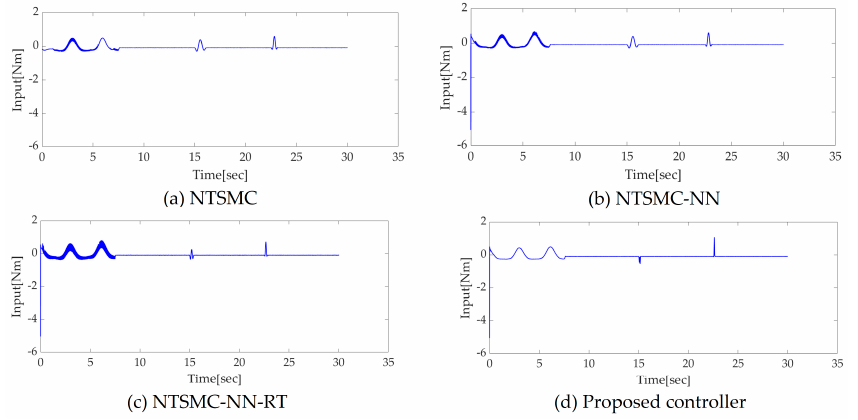
Figure 20. Mixed input θ 1 control input performance. ( a ) NTSMC input result; ( b ) NTSMC-NN input